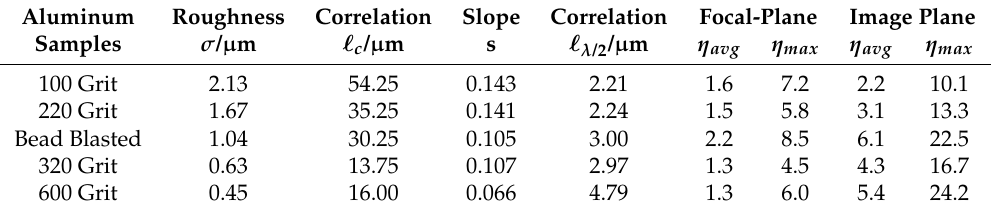
Table 1. Summary table for the five aluminum samples. Roughness ( σ ) is the standard deviation of the sample surface height. Correlation ( (cid:96) c ) is the autocorrelation shift to reduce the maximum value by e − 1 . Slope (s) is the RMS (root mean square) surface slope. Correlation ( (cid:96) λ /2 ) is the lateral distance required to change the surface height by λ / 2 at the RMS slope (s). The samples average enhancement ( η avg ) and maximum enhancement ( η max ) achieved with each optical setup is included.